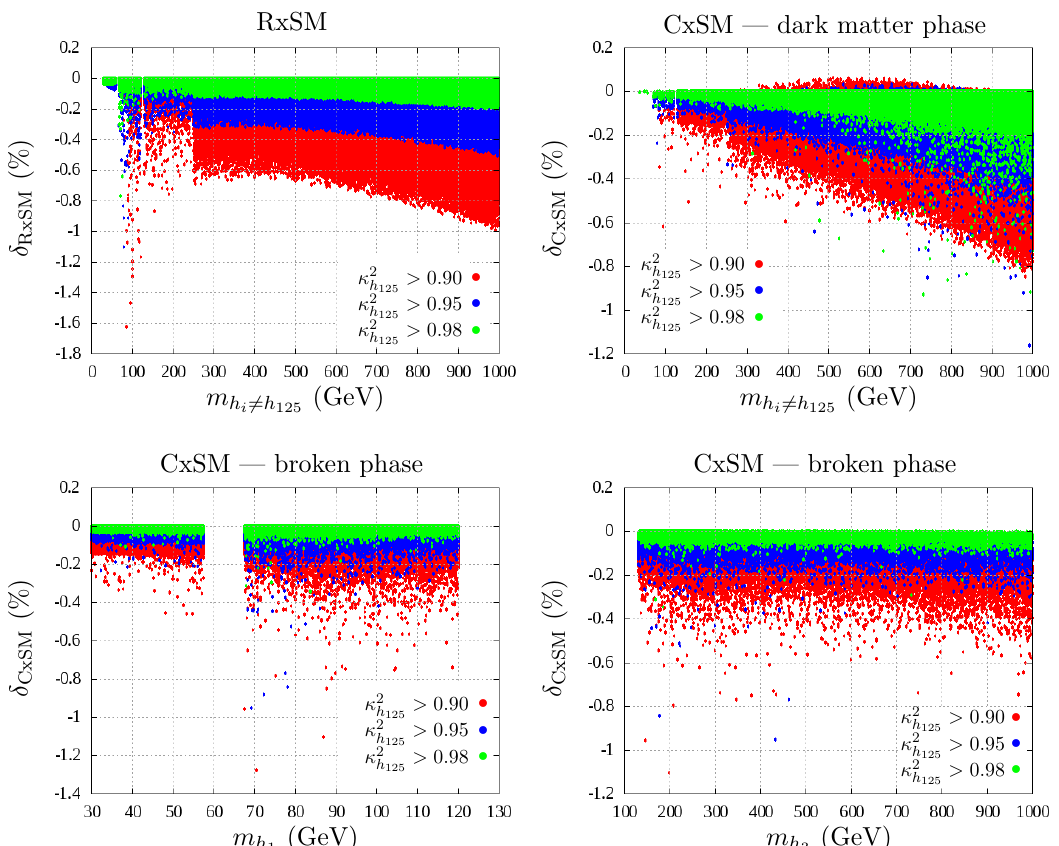
Figure 3 . Gluon fusion corrections : in all panels we present the NLO EW scalar contribution to the correction to gluon fusion production of the SM-like Higgs (vertical axis), versus the mass of one of the new non-SM like Higgs bosons (horizontal axis), for the three models. Top left , the RxSM; top right , the CxSM dark phase with the non-SM like Higgs boson mass in the horizontal axis; bottom , the CxSM broken phase with either the lighter (left) or the heavier (right) of the non-SM like Higgs masses in the horizontal